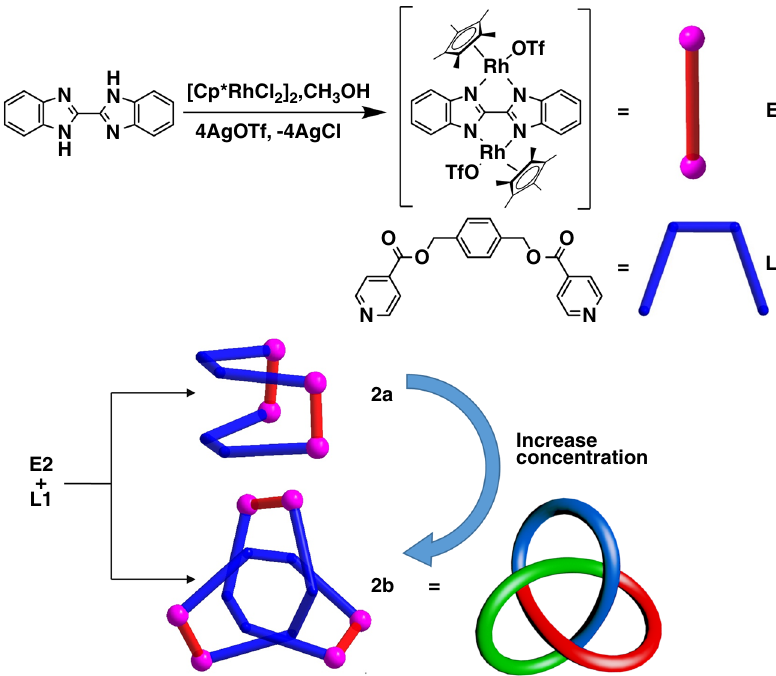
Fig. 2 Synthesis of tetranuclear macrocycle 2a and trefoil knot 2b . Schematic representation of the synthesis of E2 and the stick model of E2 ; Schematic representation and stick model of L1 ; Increasing the concentration of 2a can result in gradual transformation of 2a into 2b